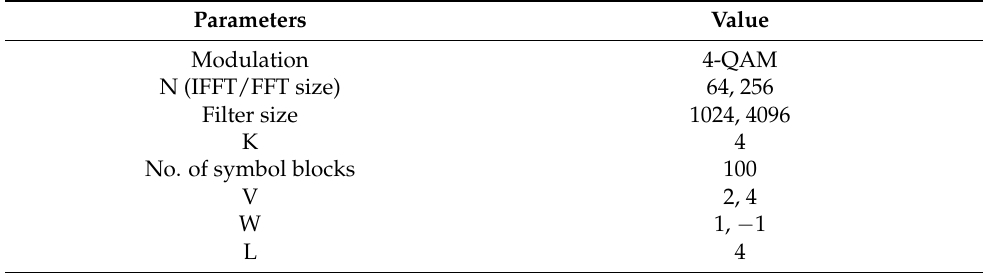
Table 2. Simulation parameters for PAPR (peak-to-average power ratio) calculations.